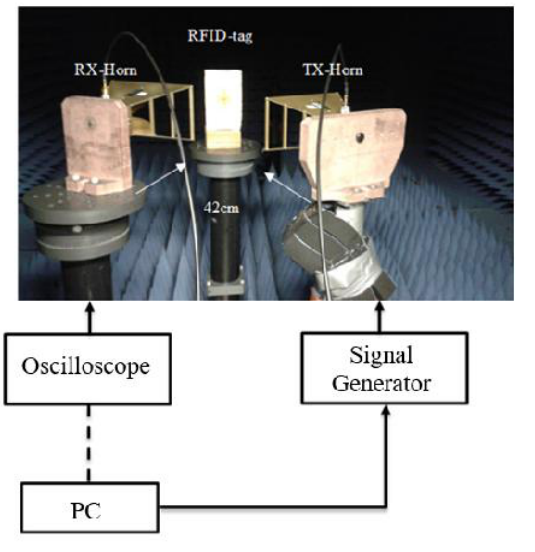
Figure 8: Power activation measurement